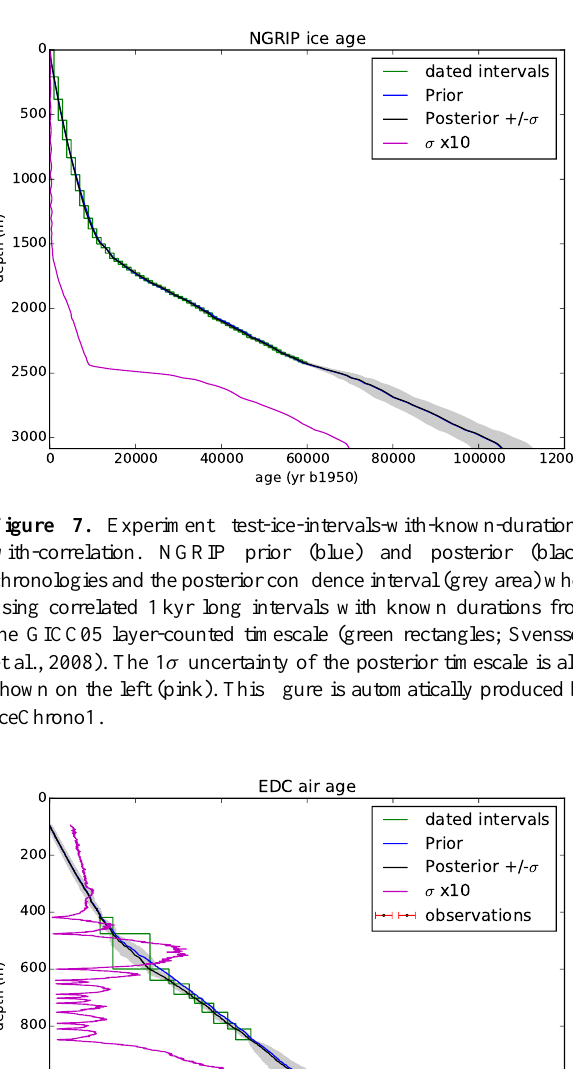
during the iterative optimization